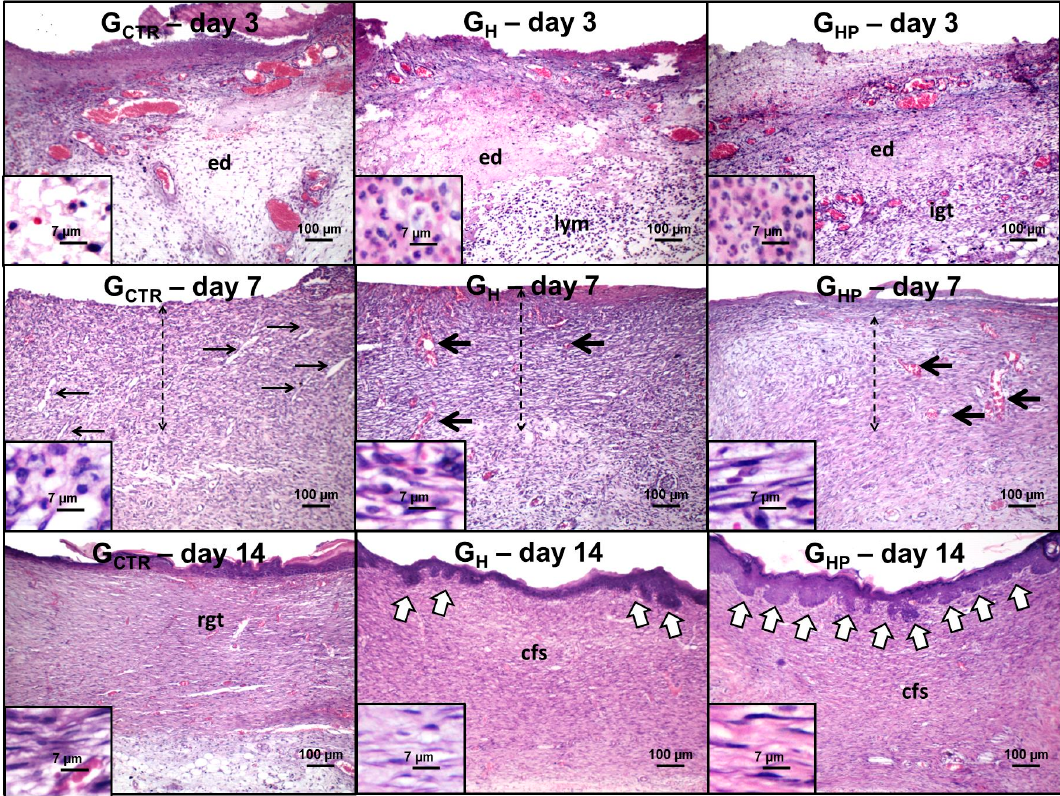
Figure 7. Photomicrographs of hematoxylin / eosin-stained histological sections representative of histological wound healing versus the time course of the experiment. Day 3: Wounds present intense edema (ed) and infiltration of polymorphonuclear neutrophils; note the lymphocyte-rich infiltrate (lym) and immature granulation tissue (igt) in the bottom of G H and G HP , respectively (100 × ). Polymorphonuclear neutrophil (small lobular nuclei) and lymphocytes (dark round nuclei) are highlighted in higher magnification (800 × ). Day 7: Thick strips of granulation tissue are observed in all groups (dashed arrows); irregular and slit-shaped capillary blood vessels concentrated in the edge are seen in G CTR (thin arrows), whereas dilated hyperemic vessels (thick arrows) are observed throughout the wound areas in G H and G HP (100 × ). Note the lower content of inflammatory cells in G HP . Stromal spindle cells (fibroblast and endothelial-like cells) are highlighted at higher magnification (800 × ). Day 14: Residual vascular granulation tissue (right) is observed in G CTR , but a cellular primary fibrous scar (cfb) is seen in G H and G HP . Epithelial buddings (compatible with rudimentary cutaneous appendages) (white arrows) are found in the edges of the wound area in G H but over the full epithelial surface in G HP (100 × ). Stromal spindle cells (fibroblast-like cells) are highlighted in higher magnification (800 × ). G CTR (Control Group), G H (Group with hydrogel sodium alginate / gelatin (80:20), and G HP (Group hydrogel with AgNP 4 mM AgNO 3